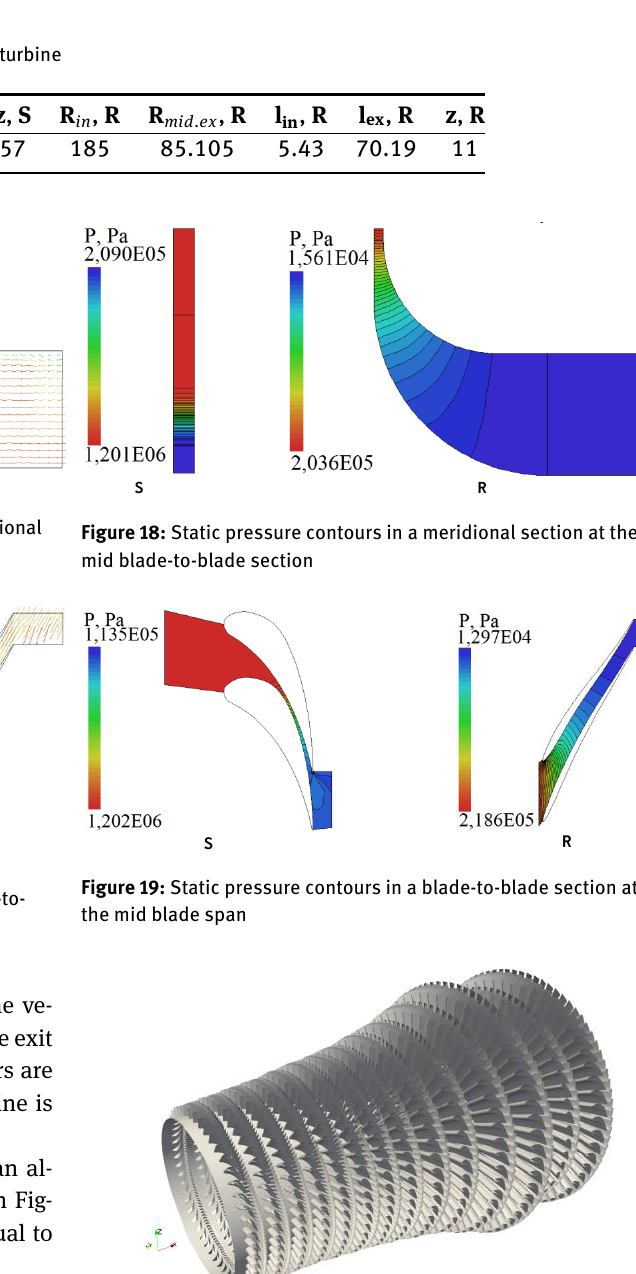
Figure 20. Three-dimensional visualization of a new T-125/150-12,8 CMP turbine Figure 20: Three-dimensional visualization of a new T-125/150-12,8